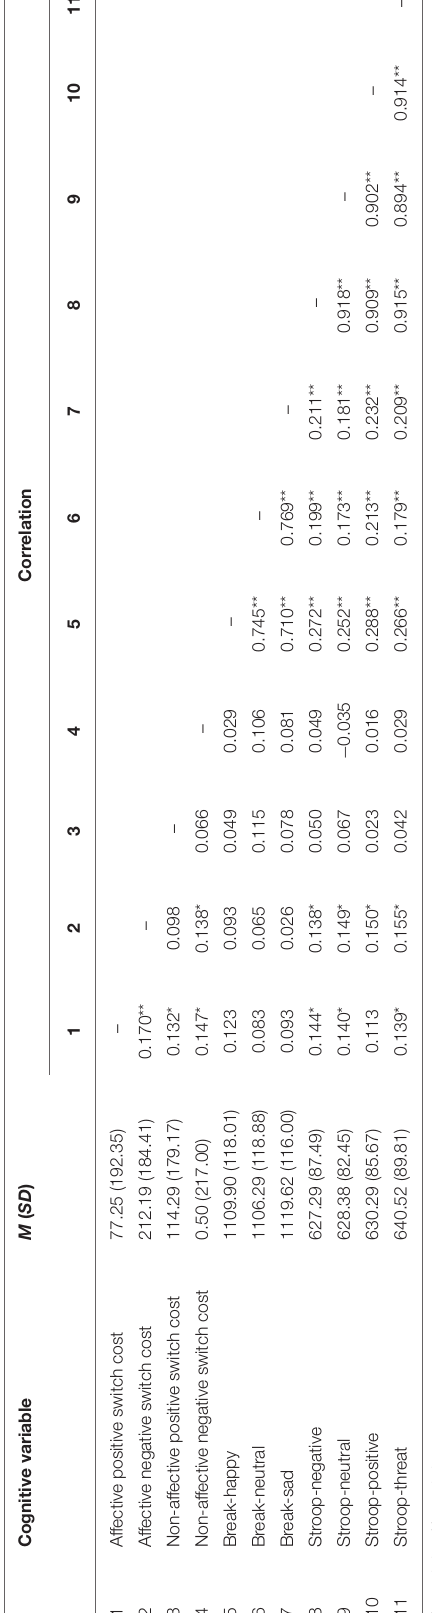
TABLE 3 | Predicting the level and trajectory of brooding.